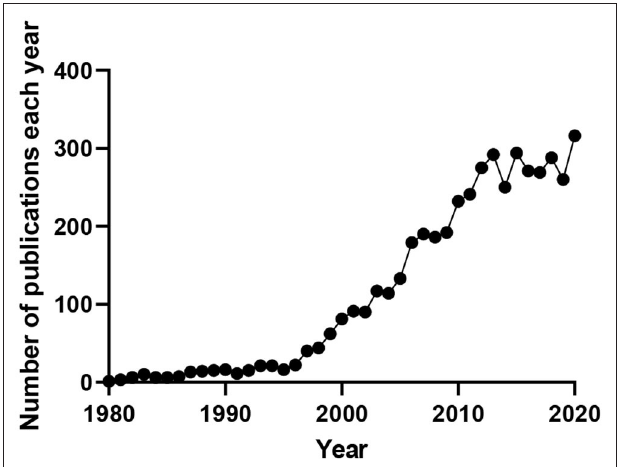
FIGURE 1 | Number of publications produced per year containing the terms “M-current,” “KCNQ(X),” or “Kv7(.X).” Data obtained from